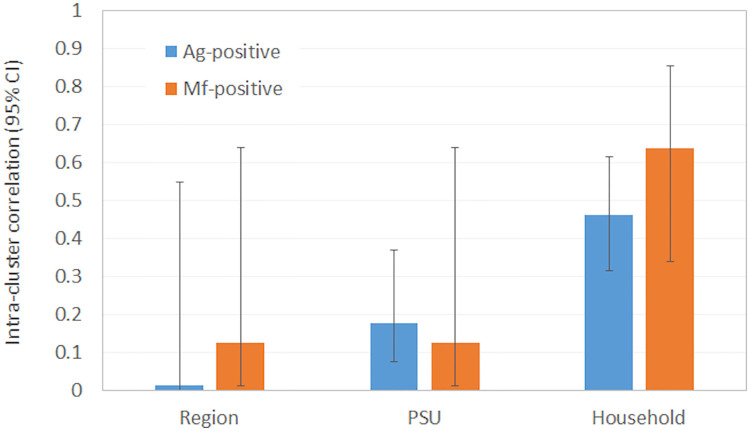
Intra-cluster correlation for Ag-positive and Mf-positive individuals at region, PSU, and household levels.